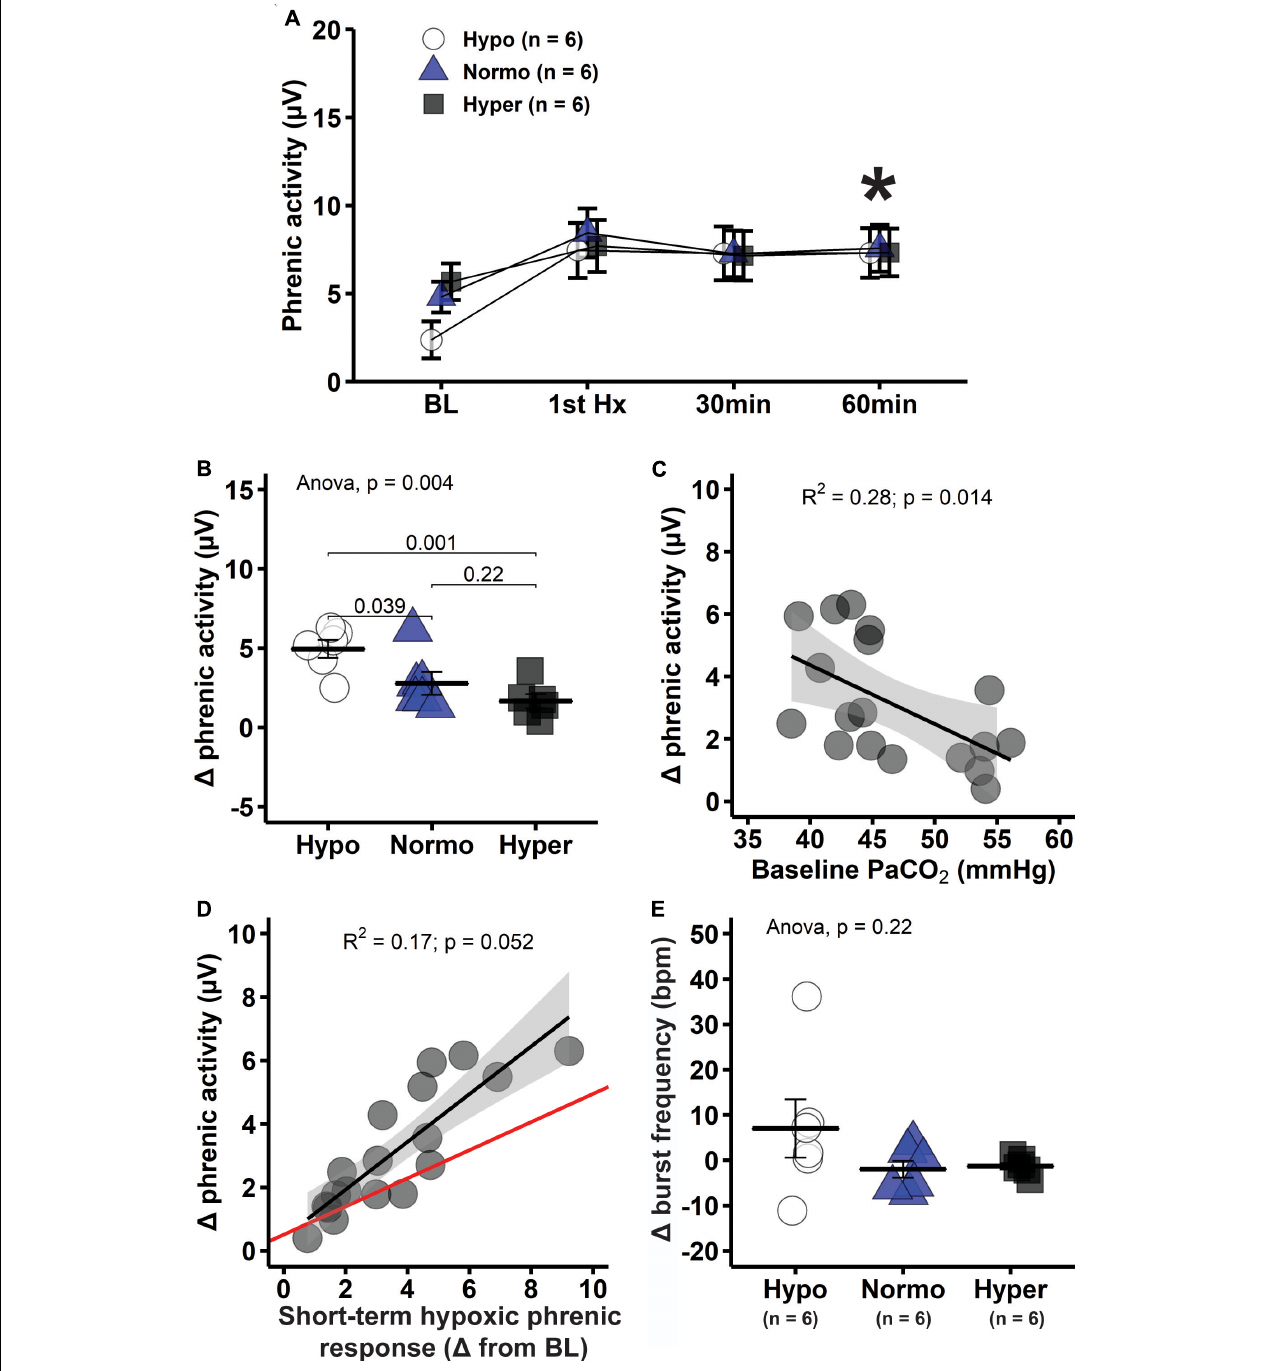
FIGURE 5 | Hypocapnic rats presented the greatest pLTF, which decreases progressively with increasing PaCO 2 . (A) Average phrenic burst amplitude at specific times during mAIH protocol. Asterisk indicates significant differences at 60 min post-mAIH compared to baseline within hypocapnic, normocapnic and hypercapnic group (mixed ANOVA; p = 0.002514 for group × time interaction). (B) Average change in phrenic burst amplitude from baseline to 60 min post-mAIH. (C) Linear regression between baseline PaCO 2 and change in phrenic burst amplitude from baseline to 60 min post-mAIH. (D) Linear regression between short-term hypoxic phrenic response and change in phrenic burst amplitude from baseline to 60 min post-mAIH. Bayesian regression line (red) describes the association between short-term hypoxic phrenic response and pLTF magnitude, taking into account prior data from our laboratory (Fuller et al., 2000; Baker-Herman and Mitchell, 2008). The 95% confidence interval of the regression slope was 0.4 and 0.5. (E) Average change in phrenic burst frequency from baseline to 60 min post-mAIH. Data are presented as mean ± standard error of the mean.